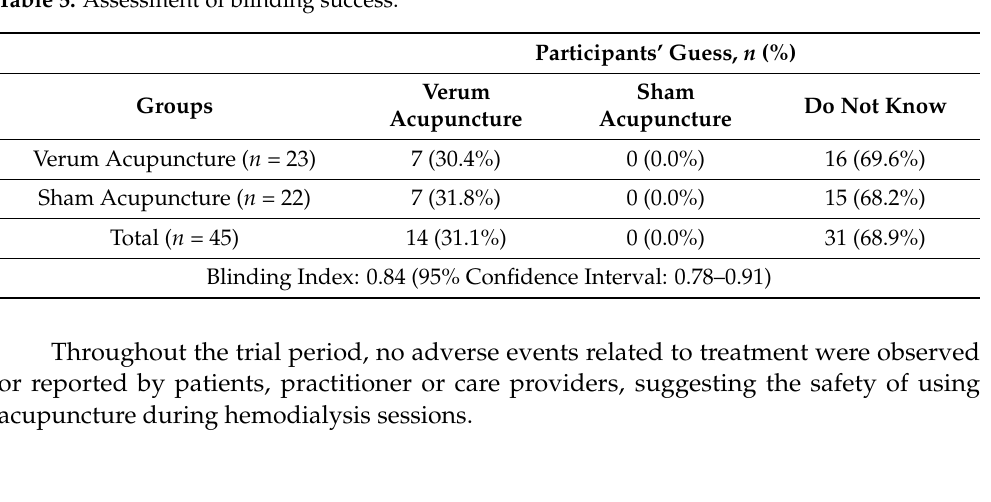
Table 5. Assessment of blinding